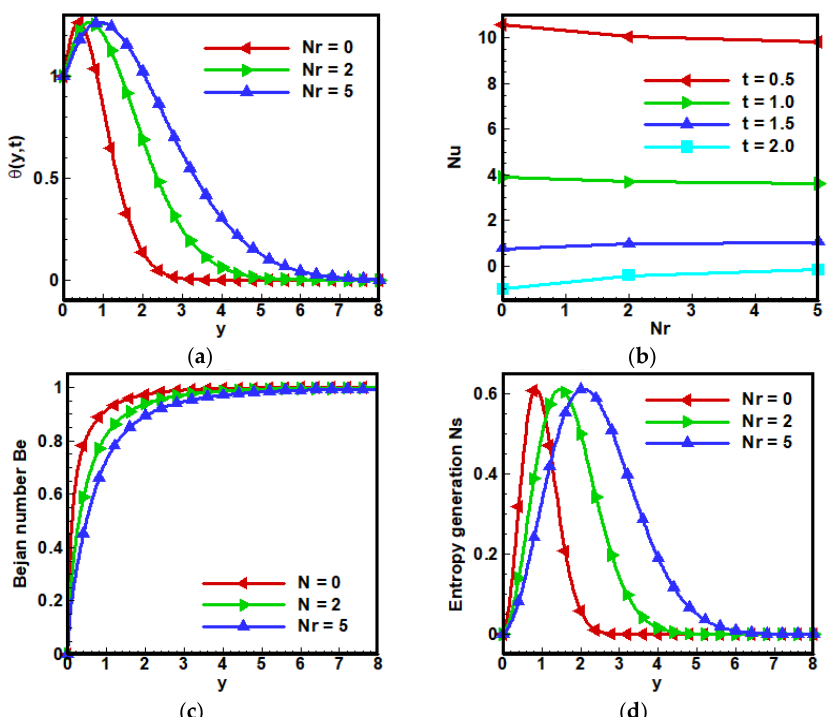
Figure 7. Influence of thermal radiation parameter 𝑁𝑟 on ( a ) dimensionless velocity profile, ( b ) non-dimensional temperature profile, ( c ) Bejan number and ( d ) entropy generation when Λ (cid:2869) = 0.6,Λ (cid:2870) = 0.5,𝐺𝑟 = 5,𝐻𝑎 = 10,𝑃𝑟 =6,𝑄 (cid:2868) = 5,𝑁𝑟 = 3.5,𝑎 = −1,𝐵𝑟 = 0.5,Ω = 10,𝜙 = 0.1 . Prandtl number 𝑃𝑟 is the dimensionless number and is the ratio of momentum to thermal diffusivity. It is a fluid property but does not have any dependence on flow type. Thus, an increase in 𝑃𝑟 means heat transfer is favored to occur by momentum, not con- duction. This parameter controls the relative thickness and thermal boundary layer in heat transfer problems. Lowering the value of 𝑃𝑟 means the heat diffuses spontaneously as compared to momentum, which thickens the thermal boundary layer rather than the mo- mentum boundary layer. Therefore, an increase in 𝑃𝑟 decreases the temperature profile 𝜃(𝑦,𝑡) of fractional Maxwell fluids as expressed in Figure 8a, which expectedly decreases the Nusselt number 𝑁𝑢 . Since Bejan number 𝐵𝑒 has an inverse relation with entropy gen- eration 𝑁 (cid:3046) , due to heat transfer, that is, 𝐵𝑒 decreases with the increase in value of 𝑃𝑟 as illustrated in Figure 8.